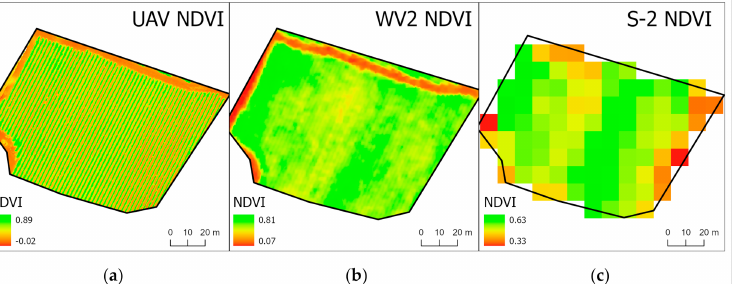
Figure 5. NDVI map from different resolution imagery (UAV, Worldview-2, Sentinel-2), source: